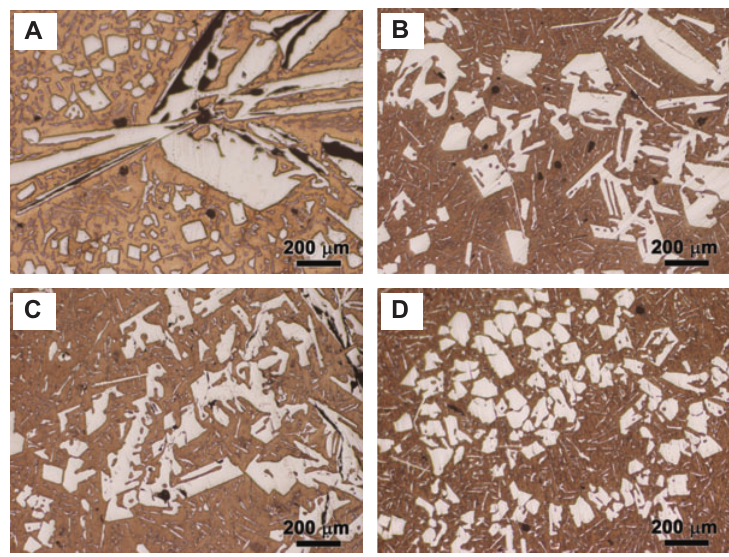
Figure 6 Effect of the TMF on the shape of the primary Si particles in the Al-22.9 wt. % Si alloy solidifi ed from 1023 K at a cooling rate of 30 K/min (A) microstructure solidifi ed in the case of no TMF during the whole process; (B) microstructure imposed a TMF of 0.15 mT during the whole process; (C) microstructure imposed a TMF of 0.30 mT during the whole process; (D) microstructure imposed a TMF of 0.45 mT during the whole